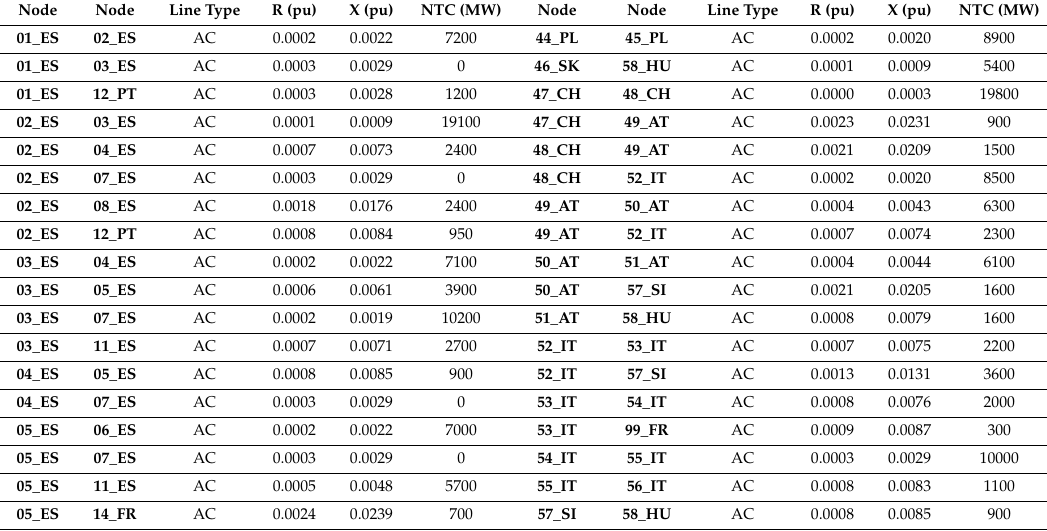
Table A1. European Network Input Data for 2030 (Adapted from